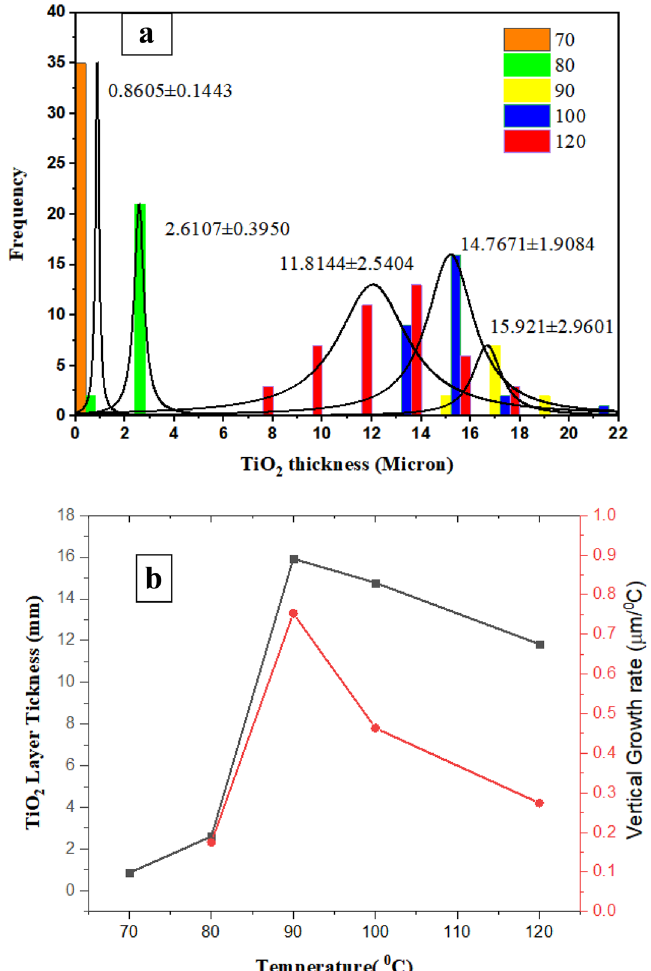
Figure 3. ( a ) The effect of temperature on ( a ) Histogram of TiO 2 layer thickness, ( b ) vertical growth